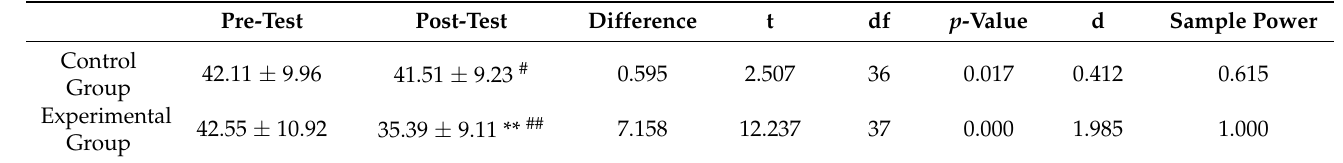
Table 5. Pre-/post-comparison of DASS-21 for two